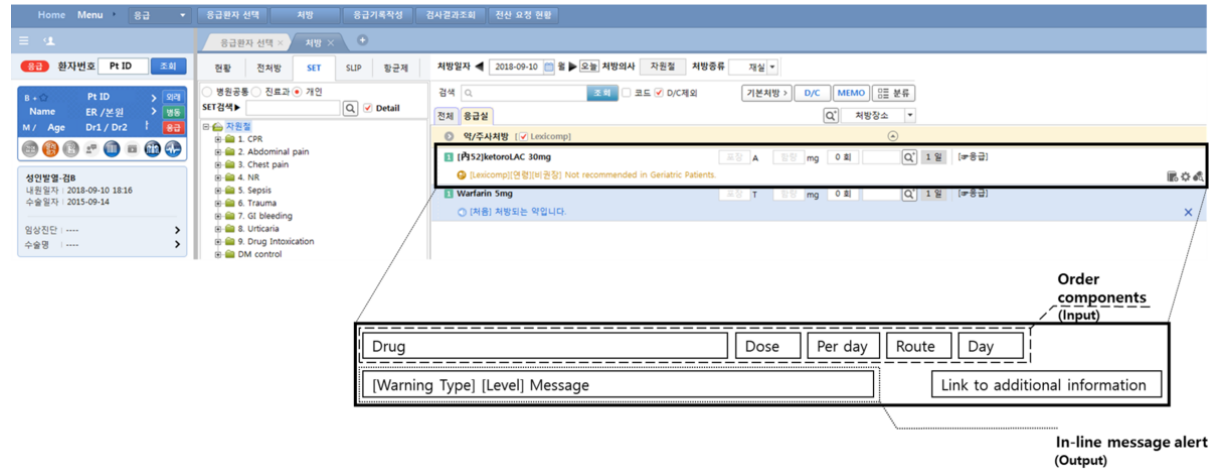
Figure 3. Screenshot of the computerized provider order entry system and features of its interface (zoomed